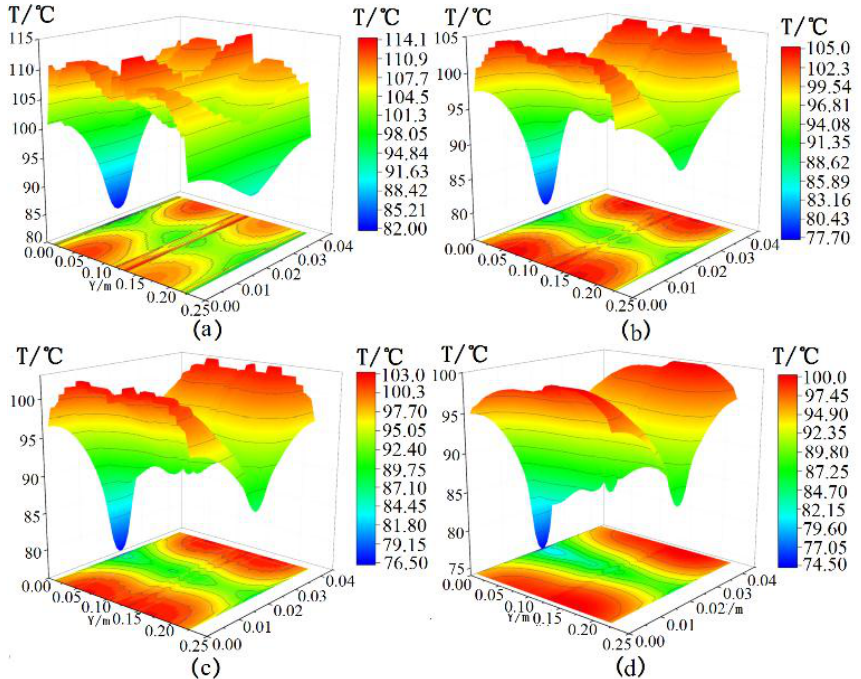
Figure 7. In the case of the stator main insulation unilateral shelling δ = 1.0 mm, the main insulation axis-radial temperature distribution in the shelling side: ( a ) The main insulation axial–radial P 13 temperature distribution; ( b ) The main insulation axial–radial P 14 temperature distribution; ( c ) The main insulation axial–radial P 15 temperature distribution; ( d ) The main insulation axial–radial P 16 temperature distribution.